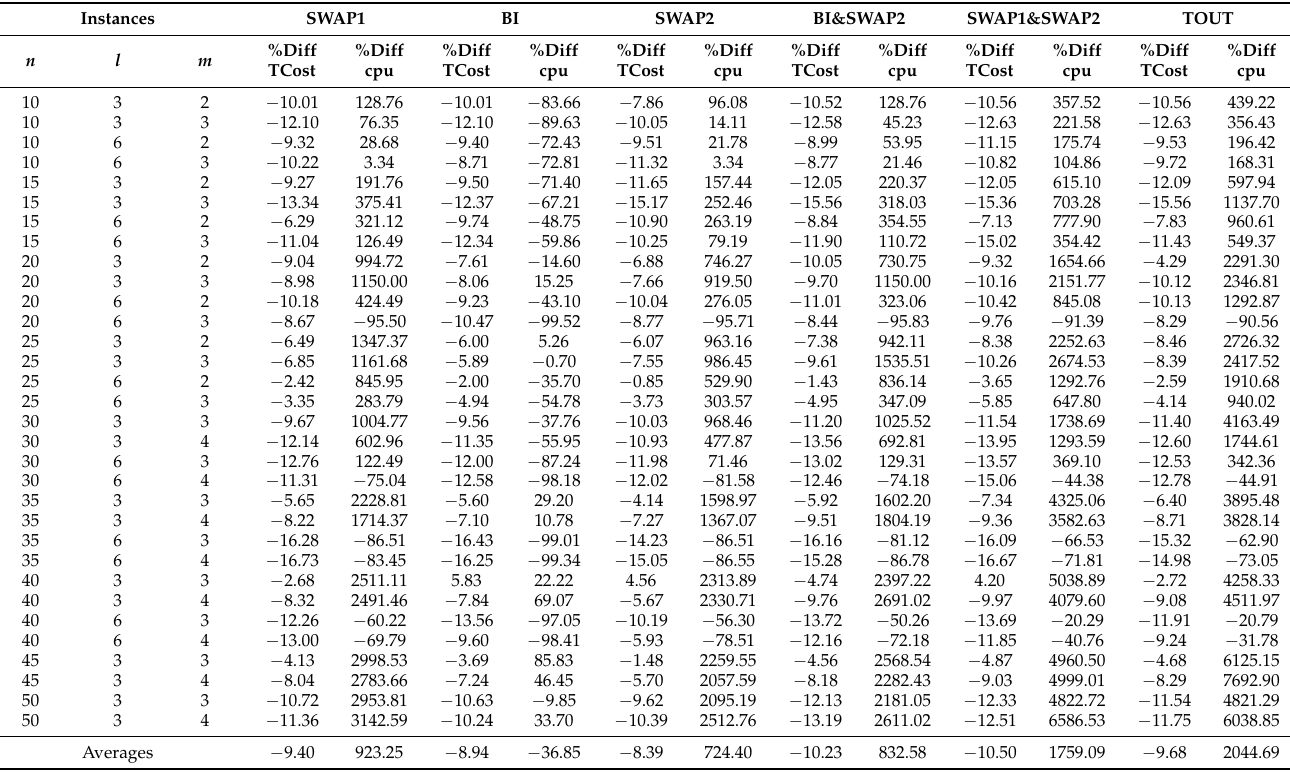
Table 15. Overall comparison of MA results with TPDH results.